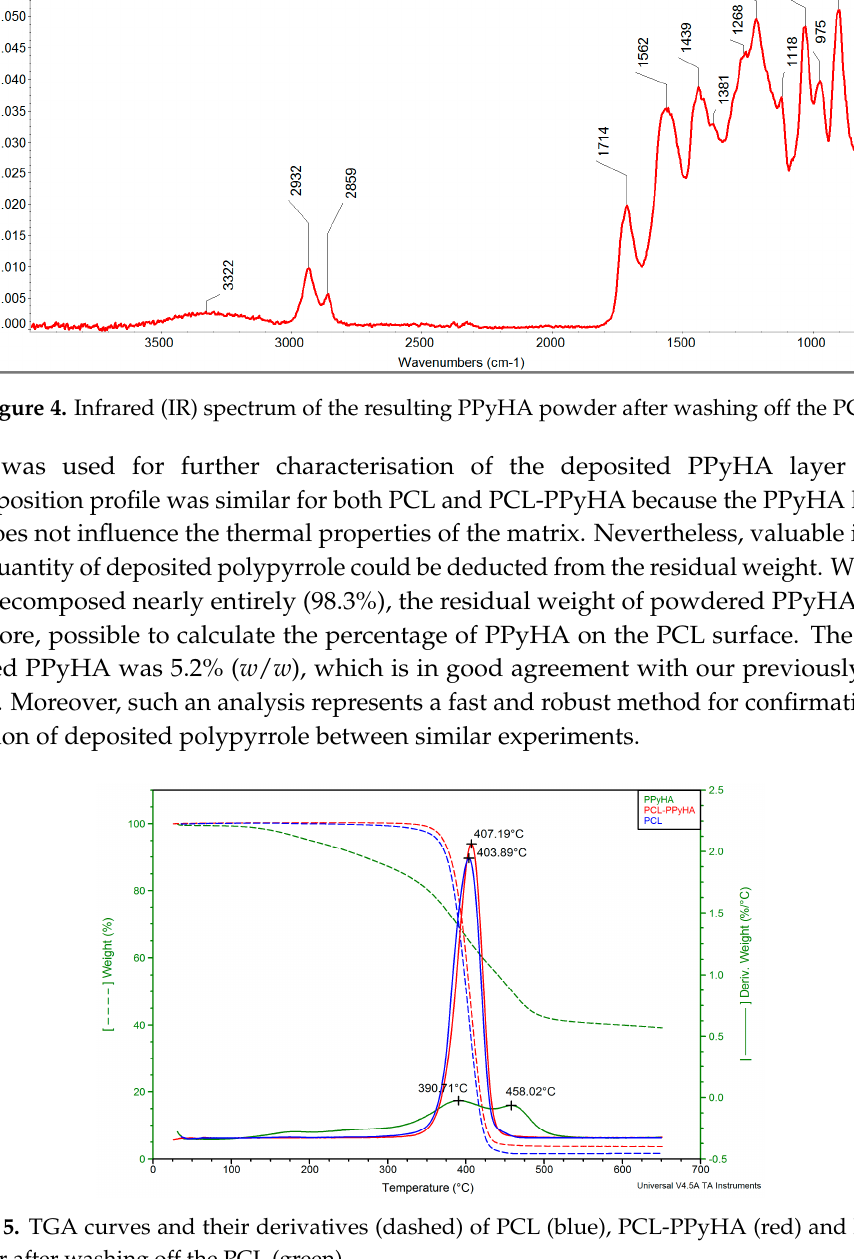
Figure 5. TGA curves and their derivatives (dashed) of PCL (blue), PCL-PPyHA (red) and PPyHA powder after washing off the PCL powder after washing off the PCL (green).